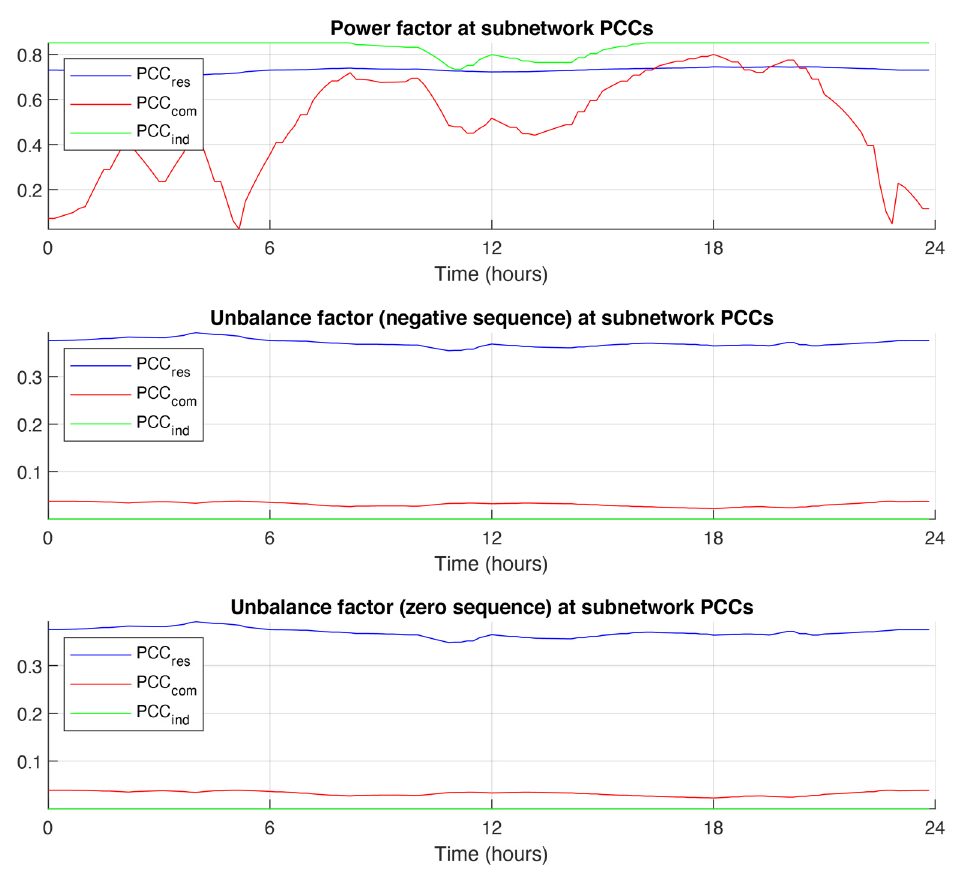
Figure 3. Behavior of three specific performance factors measured at the points of common coupling (PCCs) between each subgrid and the mains. (PCCs) between each subgrid and the